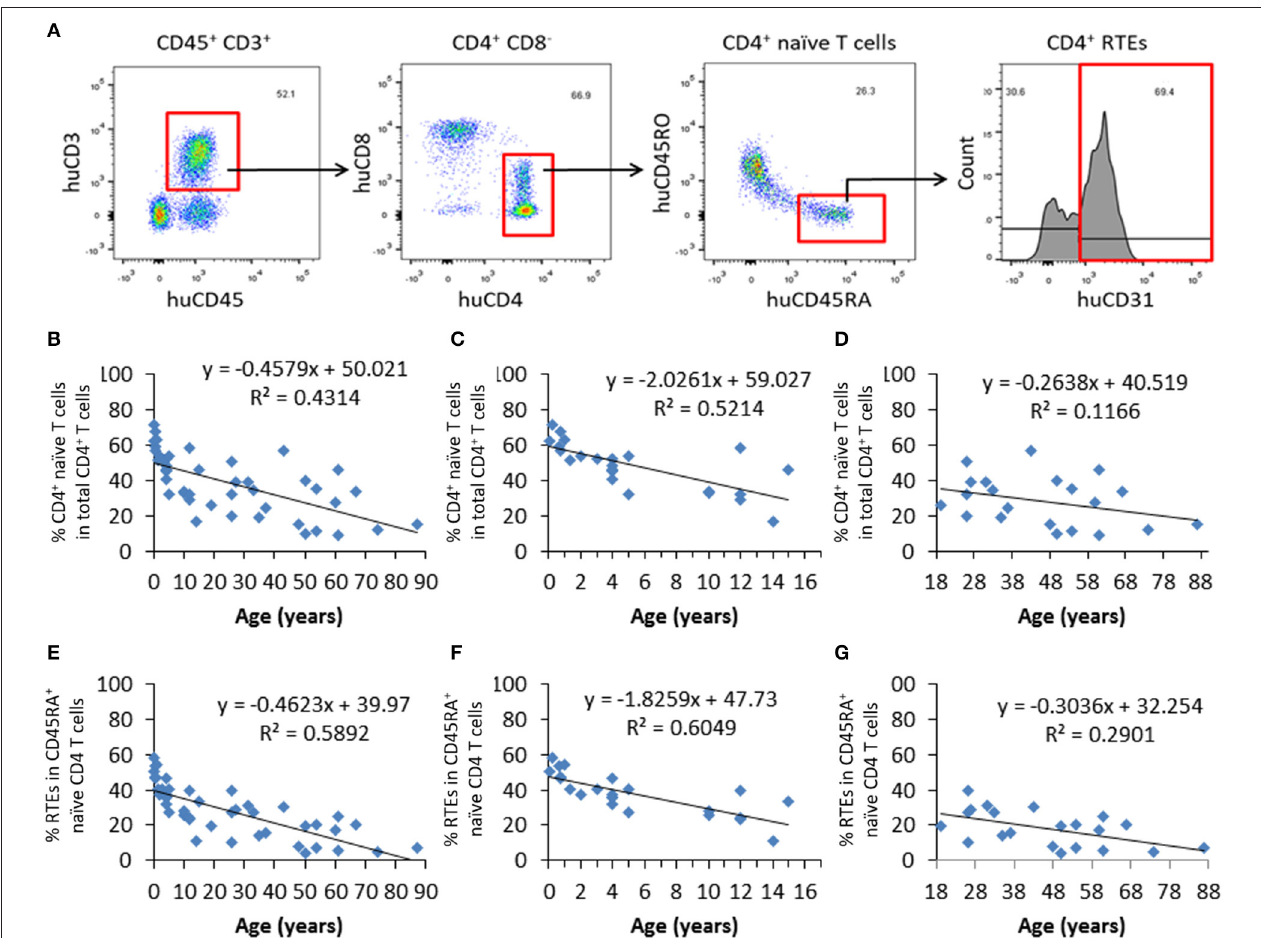
FIGURE 1 | Progressive decrease in CD4 + naïve T cells and RTEs with age in healthy humans. PBMCs from 44 healthy individuals were analyzed for the ratios of CD4 + naïve T cells and RTEs. (A) FCM profiles showing the gating strategy for identifying CD4 + naïve (CD4 + CD45RA + CD45RO − ) T cells and RTEs (CD4 + CD45RA + CD45RO − CD31 + ). (B–D) Percentages of naïve CD4 + T cells in all individuals analyzed (n = 44; B), individuals from newborn to 17 years old ( n = 23; C ), and individuals from 18 to 87 years old ( n = 21; D ). (E–G) Percentages of CD4 + RTEs in all individuals analyzed ( n = 44; E ), individuals from newborn to 17 years old ( n = 23; F ), and individuals from 18 to 87 years old ( n = 21; G ).